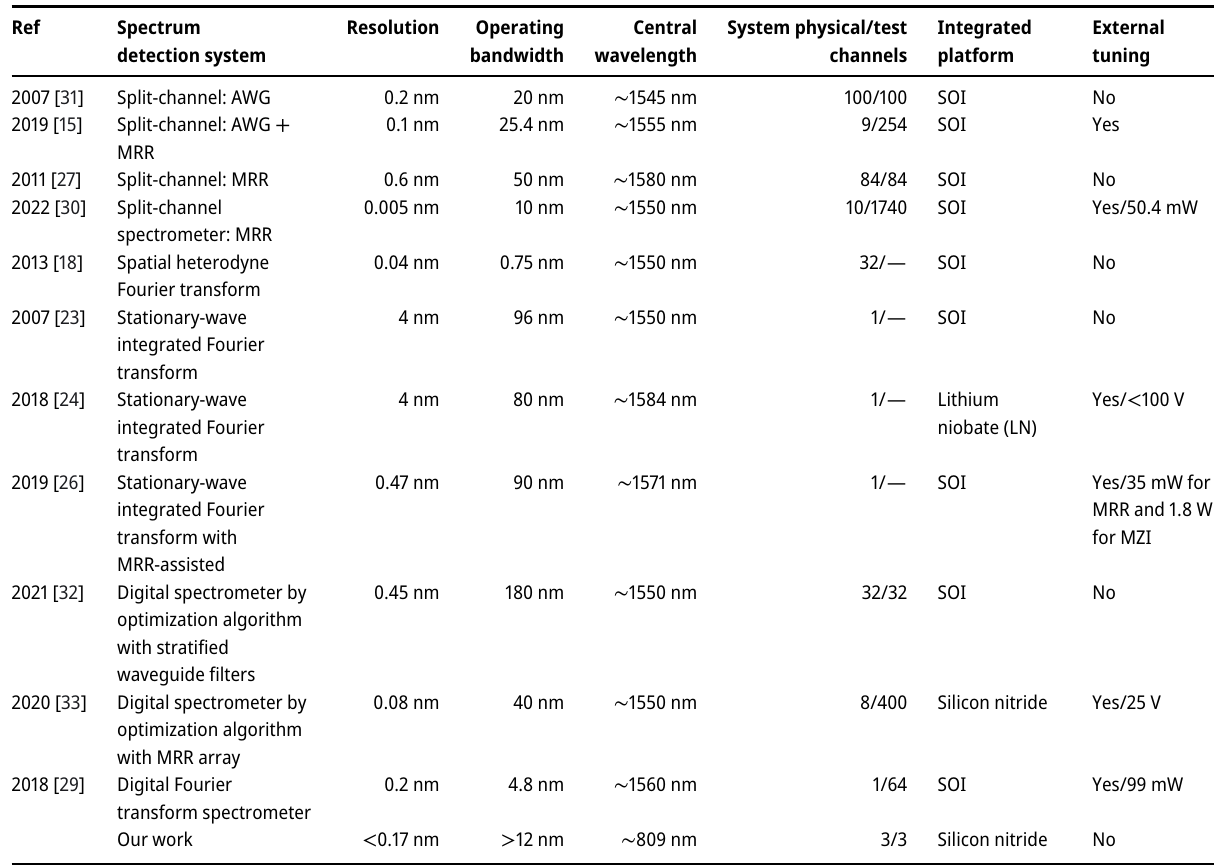
Figure 6: The reconstructed spectra by different convex optimization algorithm and single wavelength characterization. (a) The reconstructed , x , x by the least norm, norm approximation and least-squares optimization algorithm. (b) The reconstructed spectrum of laser signal with spectra x 1 2 3 the center wavelength of 784.89 nm and FWHM of 0.17 nm. (c) Reconstructed results at the center wavelength, where the reconstructed wavelength error is 0.04 nm. Table 1: Comparison of on-chip spectrum detection